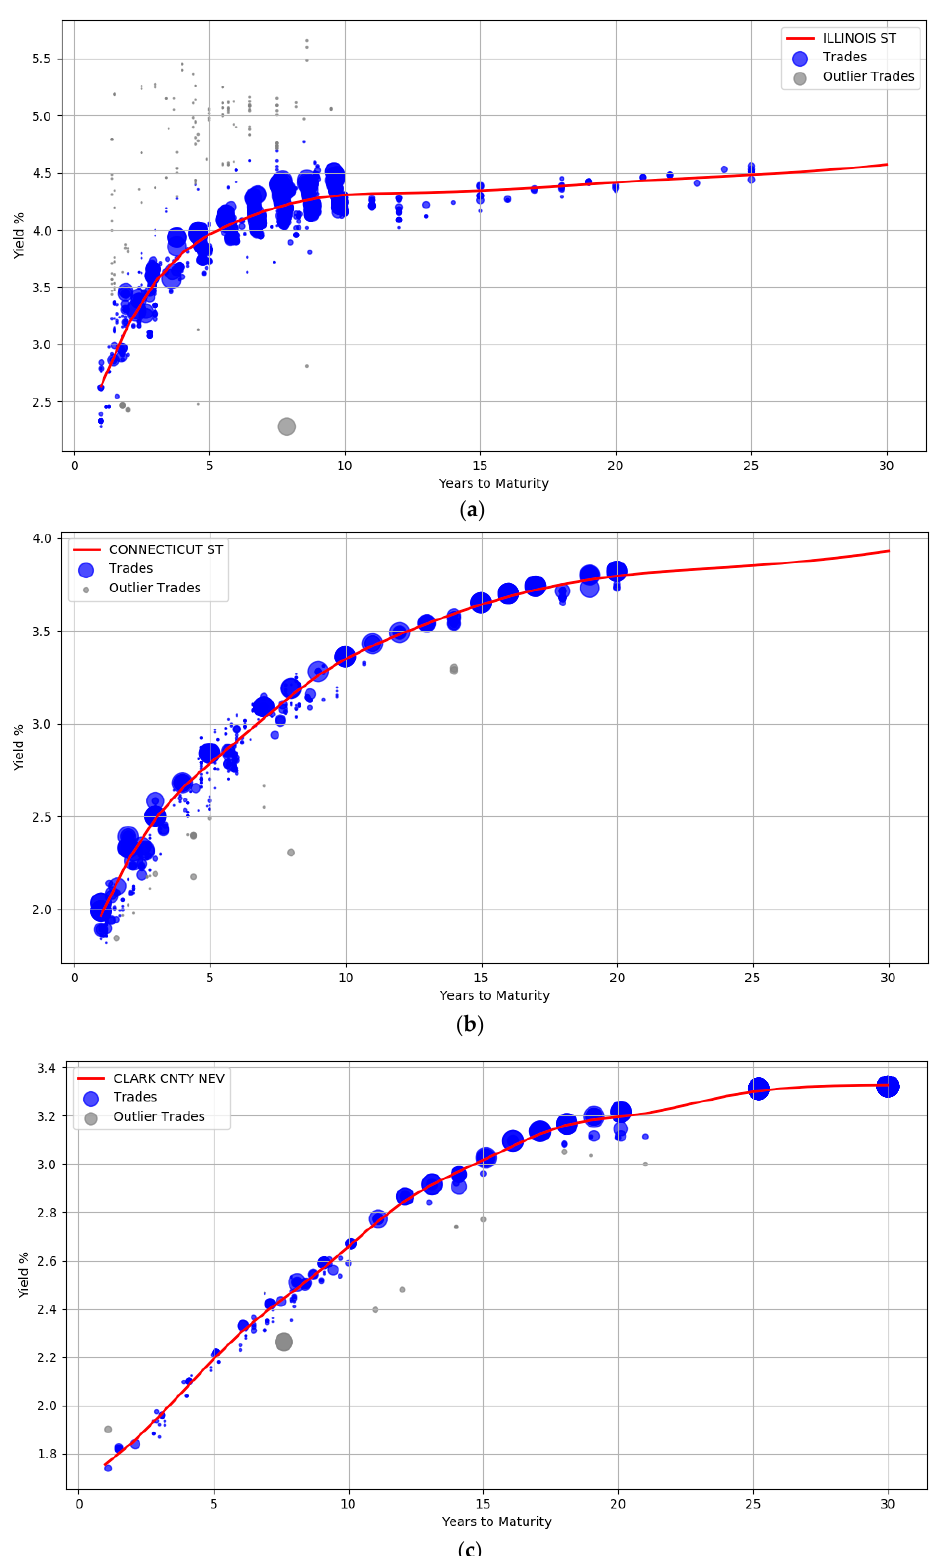
Figure 3. Trade transactions and the yield curves. The circles denote the trades weighted by their attributes. The smaller the circle, the lesser a data point’s importance. ( a ): Illinois state. ( b ): Connecticut State. ( c ): Clark Country Nevada.